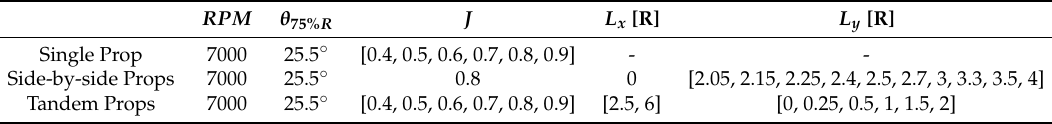
Table 1. Summary of the configurations analysed by DUST